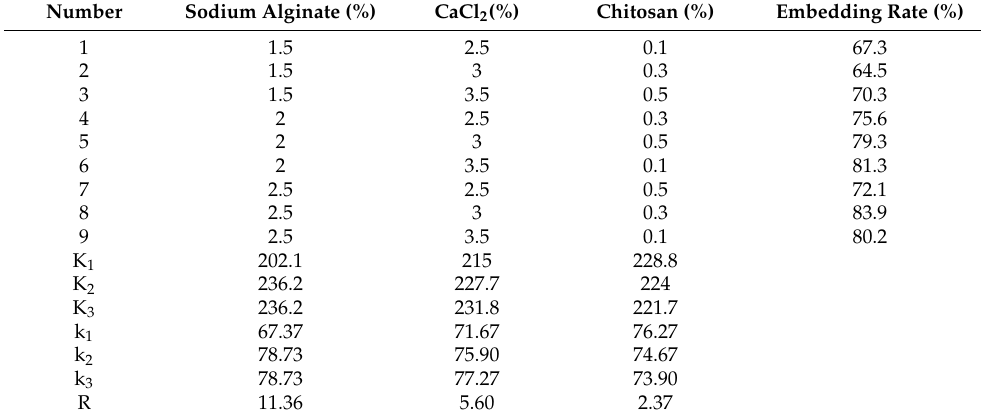
Table 1. Orthogonal experimental analysis for the influencing factors in the preparation of methyl jasmonate